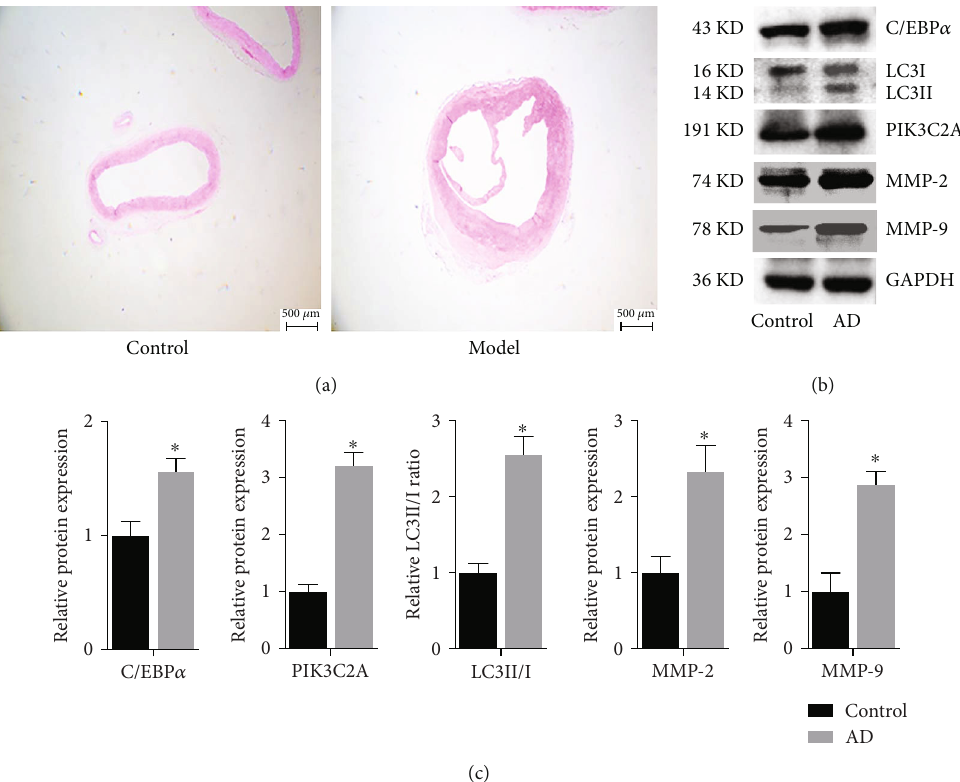
Figure 1: Establishment of aortic dissection rats reveals model-speci fi c patterns of C/EBP α , PIK3C2A, LC3, and MMPs proteins. (a) The pathological changes in aorta tissues evaluated by H&E staining ( scale bar = 500 μ m ). (b) Representative images of C/EBP α , PIK3C2A, LC3, MMP-2, and MMP-9 protein expression in aortic dissection rings determined by Western blot. (c) The expression level of indicated proteins ( ∗ P < 0 : 05 vs. control).